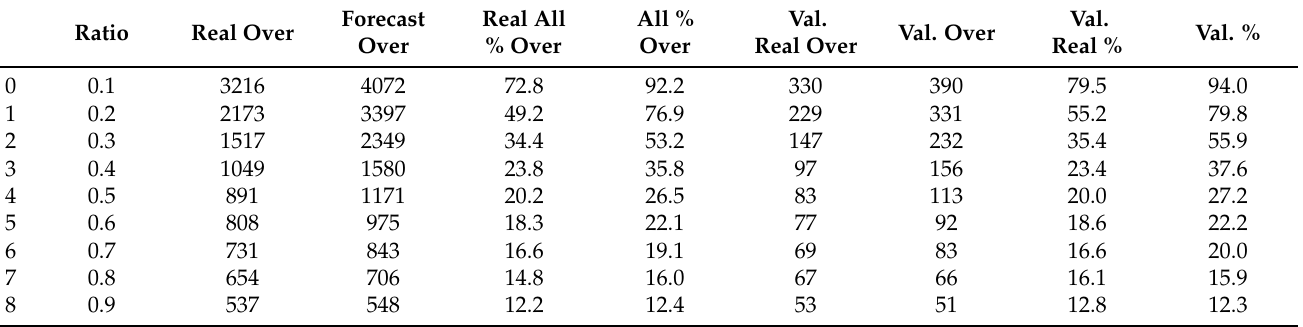
Table 6. Table of measurements for instances where real data and forecasts go above the ratio used in the